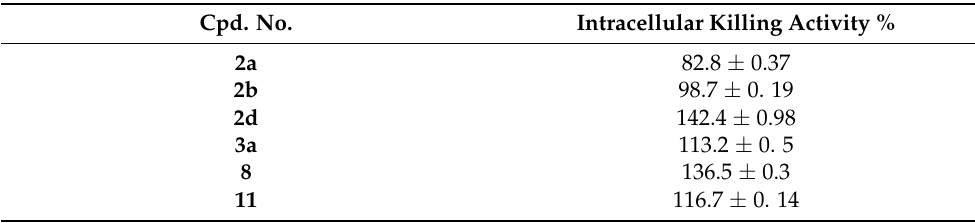
Table 7. Intracellular killing activities of the most promising derivatives.